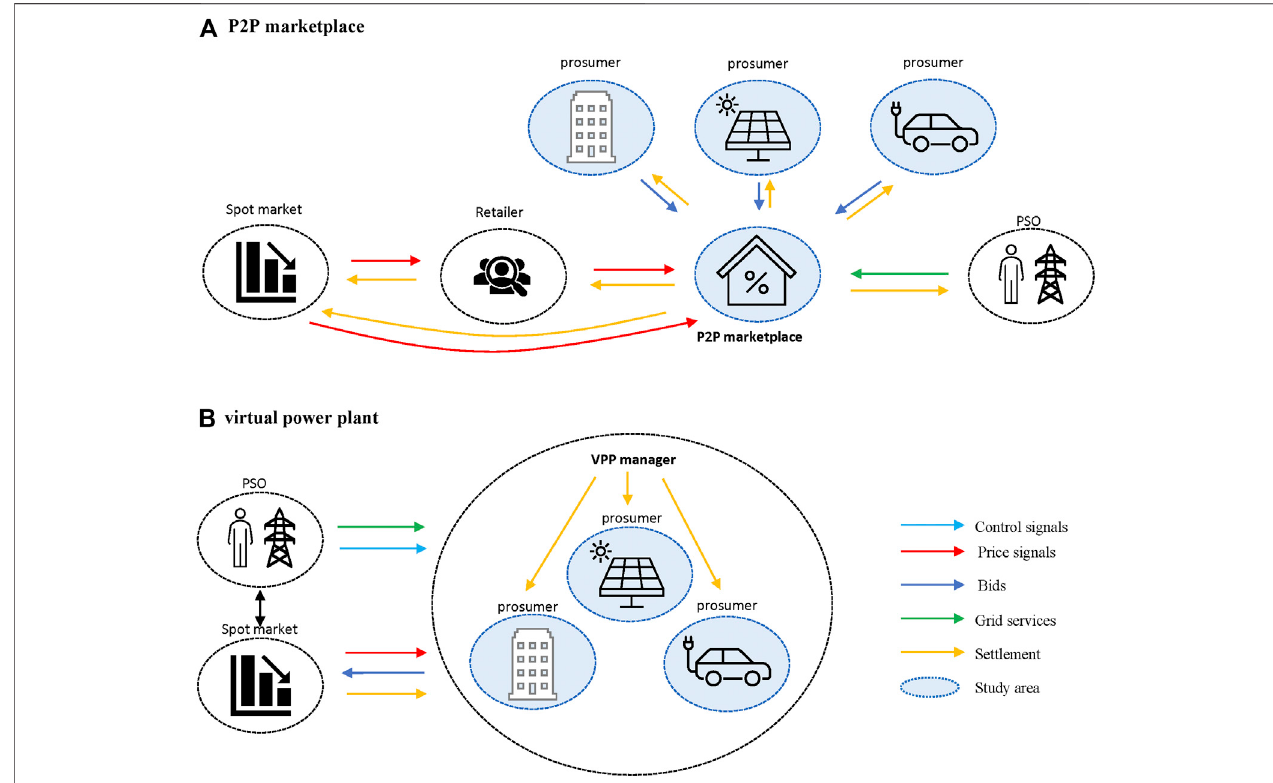
FIGURE 15 | Market integration options including P2P marketplace (A) and virtual power plant (B) for DERs in the urban district.